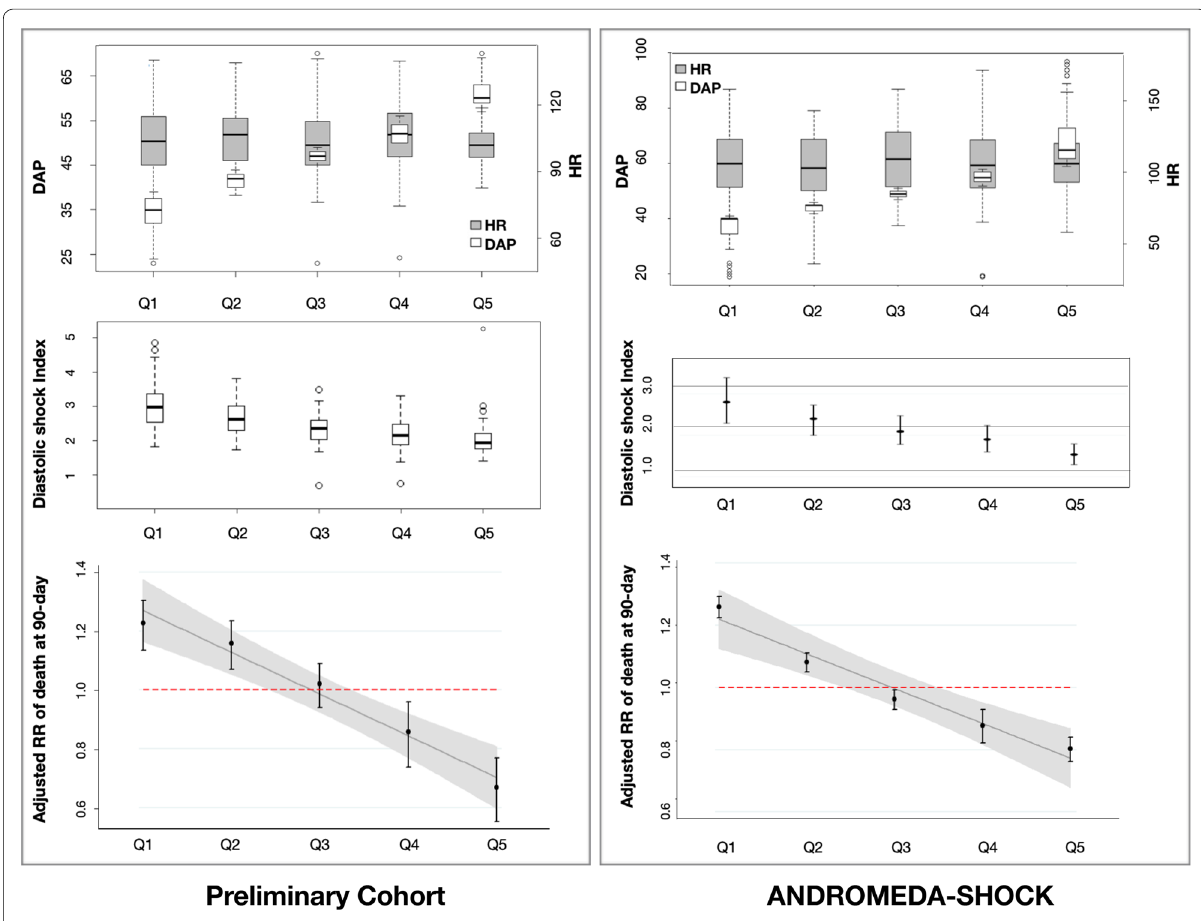
Fig. 2 Relative risk of death at day‑90 according to diastolic arterial pressure (DAP) partition in the preliminary and ANDROMEDA SHOCK populations. Diastolic arterial pressure (DAP) values from just before the start of vasopressor support were partitioned into 5 quantiles (Q1 to Q5). Distribution of heart rate (HR) and diastolic pressure (DAP) (top) displays a progressive increasing of DAP values through the quantile partitioning with their corresponding HR values, which remains similar from Q1 to Q5. The respective diastolic shock index distribution (middle) is presented through the quantile distribution. The boxes (top) delineate the interquartile range, the median is shown as a line in the middle of the box, and tails represent the 95% range. Boxplots/error bars (middle) represent medians and 95% confidence intervals of the diastolic shock index (DSI) at each quantile. Relative risks’ distributions (bottom) were calculated as described in Fig. 1. Note that adjusted relative risk of death decreases as DAP increases and subsequently DSI decreases, for similar HR